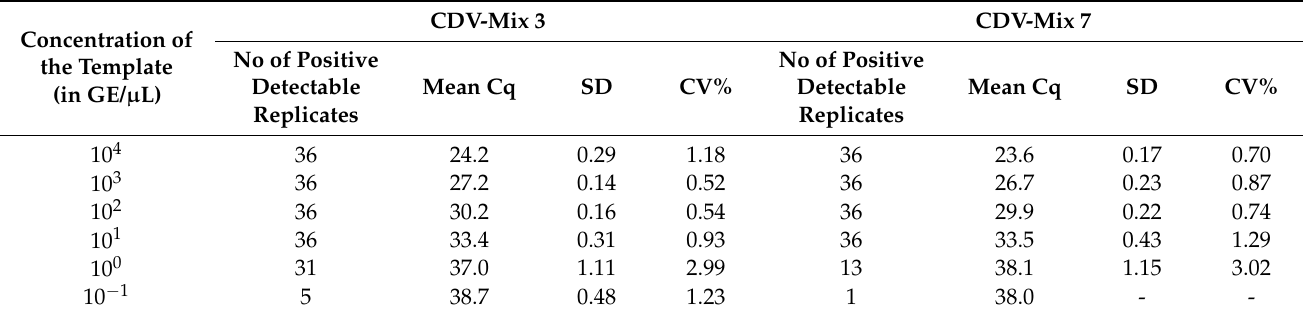
Table 2. Evaluation of the analytical sensitivity regarding CDV-Mix 3 and CDV-Mix 7. Concentration of the